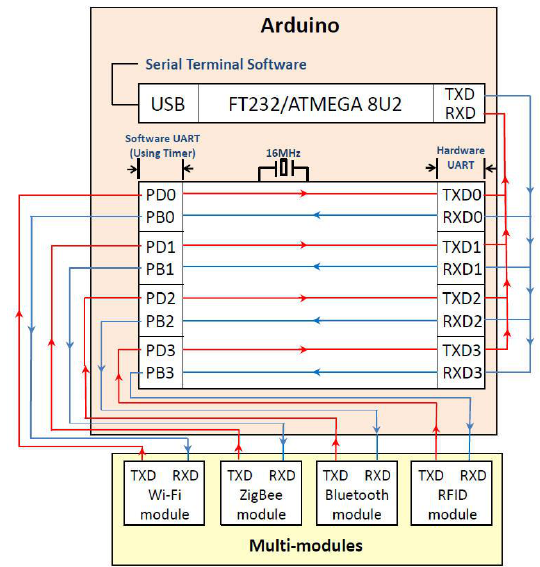
Figure 35. Arduino, Wi-Fi module, ZigBee module, Bluetooth module and RFID module data